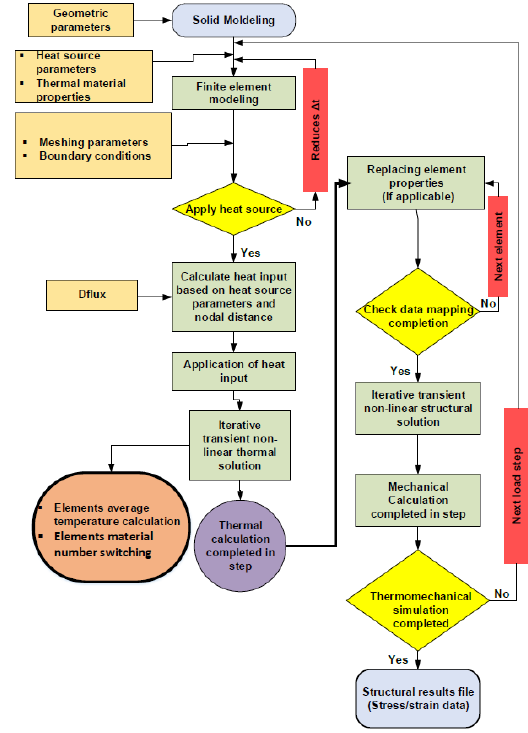
Figure 4. Detailed sequence of preprocessing, processing and post-processing developed in the thermal and thermo-mechanical simulations.